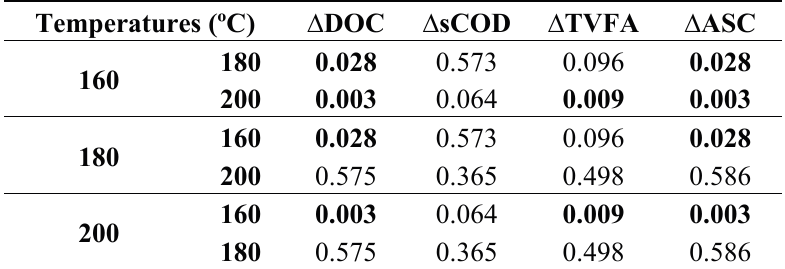
Table 3. Tukey test: multiple comparisons among levels of temperature